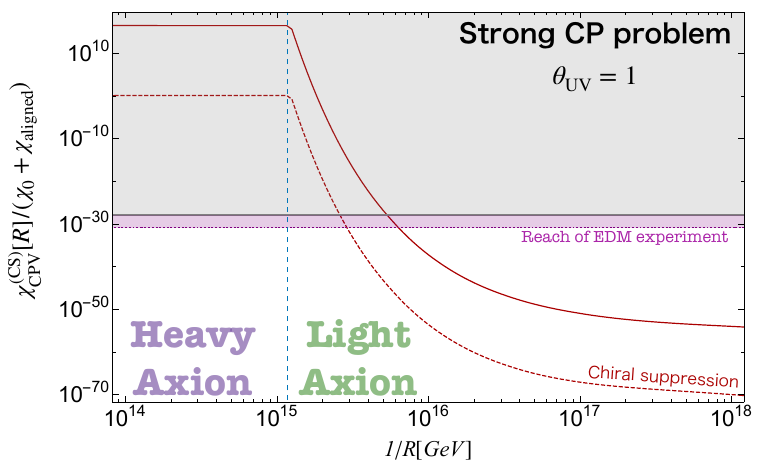
Figure 5 . Allowed regions for the extra-dimension model by numerically integrating the small instanton contributions (4.8), (4.12) and (4.16), with Λ 3 R = M 2 (dashed) line represents χ CPV / ( χ 0 + χ aligned ) ( χ CS and the future reach (purple region) is estimated by assuming θ UV ∼ 1